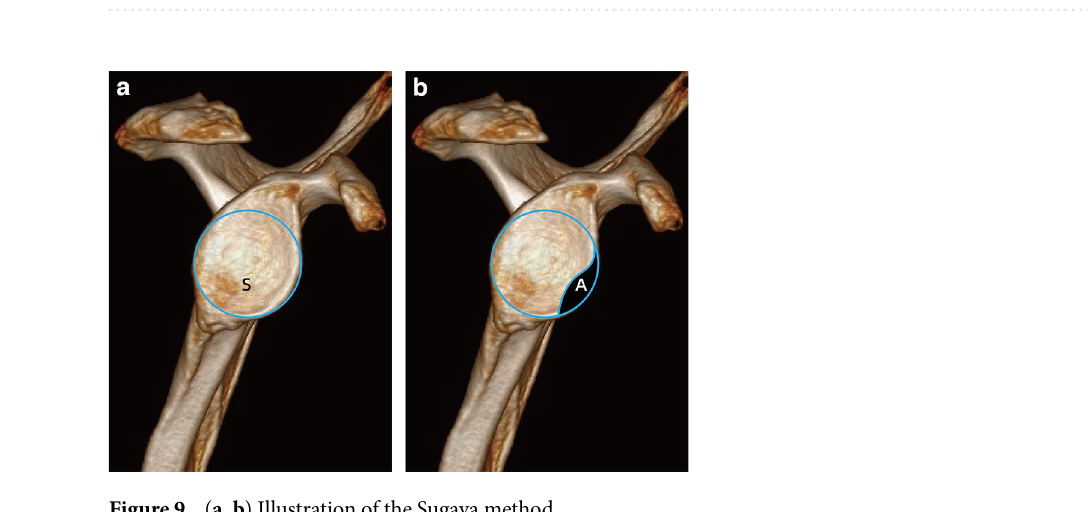
Figure 9. ( a , b ) Illustration of the Sugaya